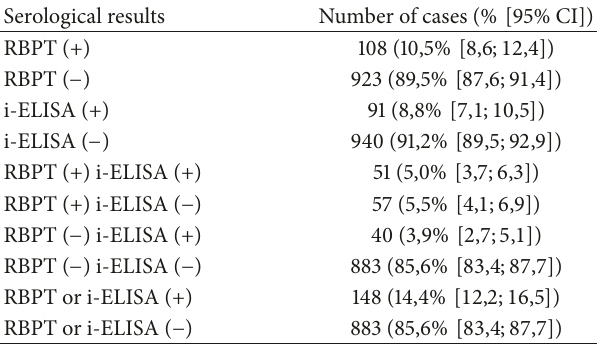
from the required authorities in Cameroon (PAPA/ADFL Table 1: Combined results of Rose Bengal Plate test and indirect Enzyme-Linked Immunosorbent Assay among cattle in the North and Adamawa Regions of Cameroun ( 𝑛 = 1031